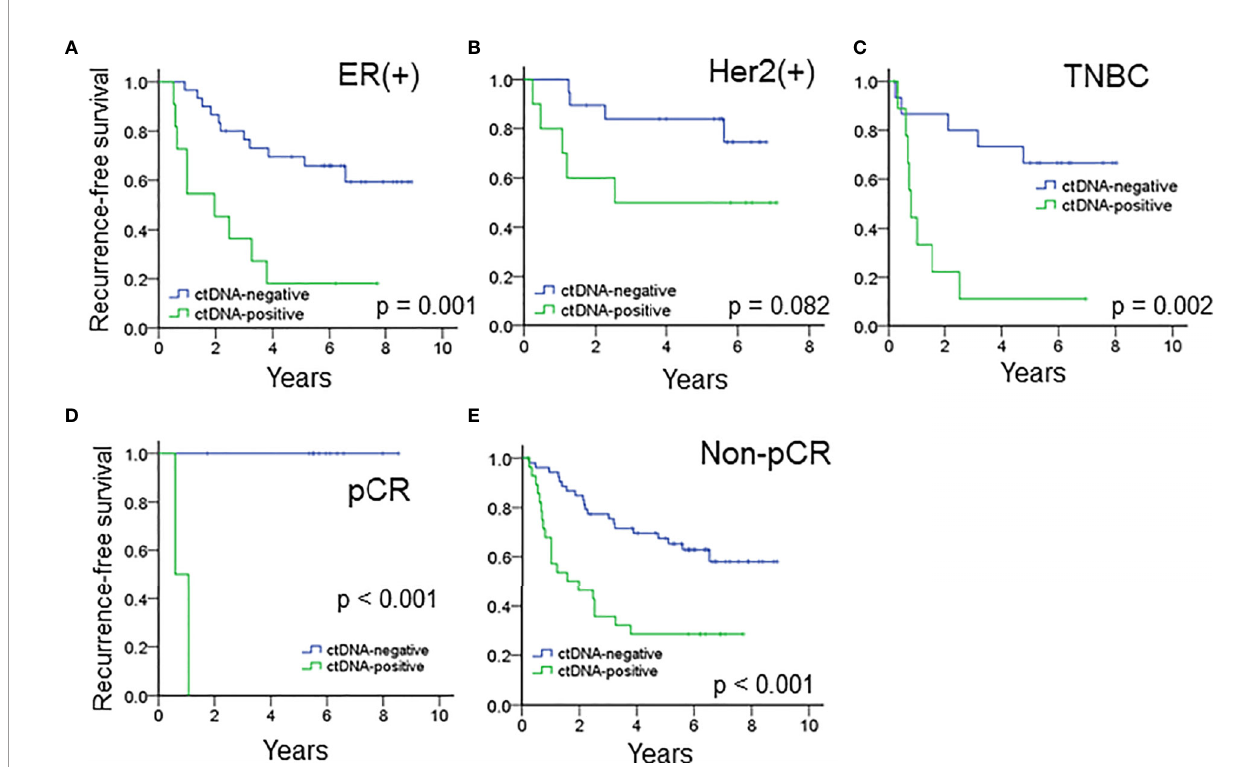
FIGURE 3 | The prognostic impact of ctDNA after NAT in patients with (A) ER(+) breast cancer, (B) Her2(+) breast cancer and (C) TNBC. ctDNA after NAT predicted RFS in (D) pCR and (E) patients who did not achieve pCR.